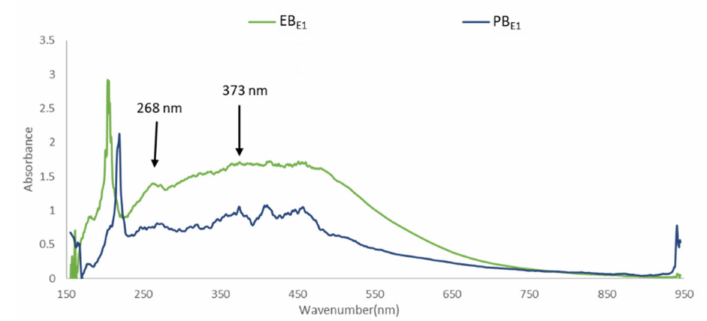
Figure 1. UV-VIS spectra of PB E1 and EB E1